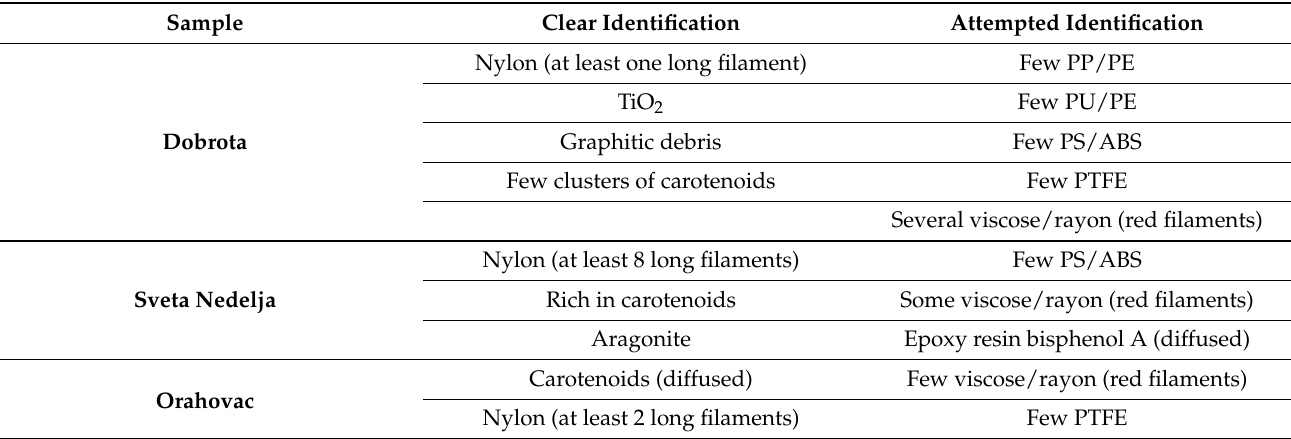
Figure 6. ( A ) Optical image and ( B ) corresponding Raman spectrum of an aragonite cluster. ( C ) Optical image of one of the many and diffused small regions containing epoxy resin bisphe- nol A (red spot). Both types of debris were found only in the Sveta Nedelja sample. Table 1. Summary of the clear (central column) and attempted (last column) visual and Raman identifications of fragments, clusters and filaments on the surface of the membranes obtained by filtering the solutions resulting from sample digestion. The first column reports the collection location of the analyzed